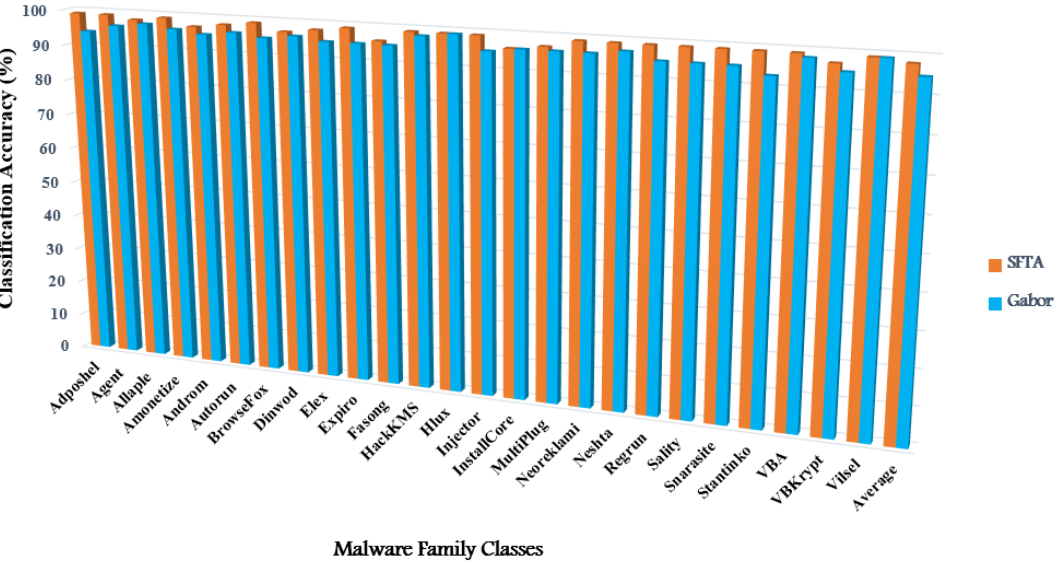
Figure 10. The classification Accuracy-based SFTA and Gabor features across GDA Classifier.